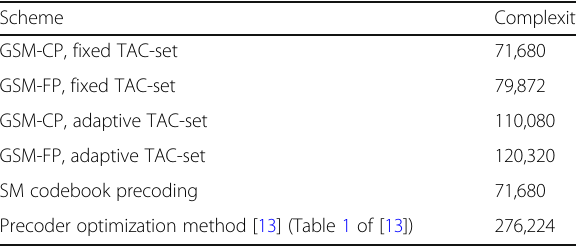
Table 3 Complexity comparison for N r = 4, B = 64, and